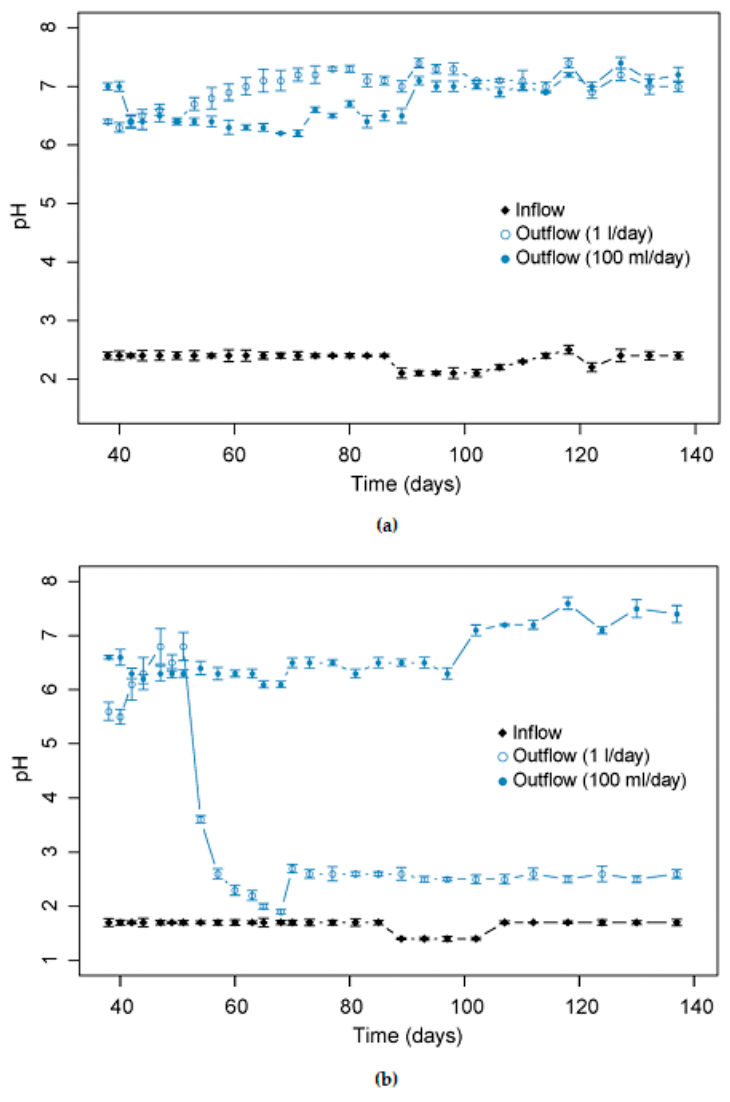
Figure 3. pH variations in reactors that were inoculated with acid influent waters—dissolution groups S2 ( a ) and S3 ( b )—and were operated continuously for 14 weeks after 37 days of batch operation.